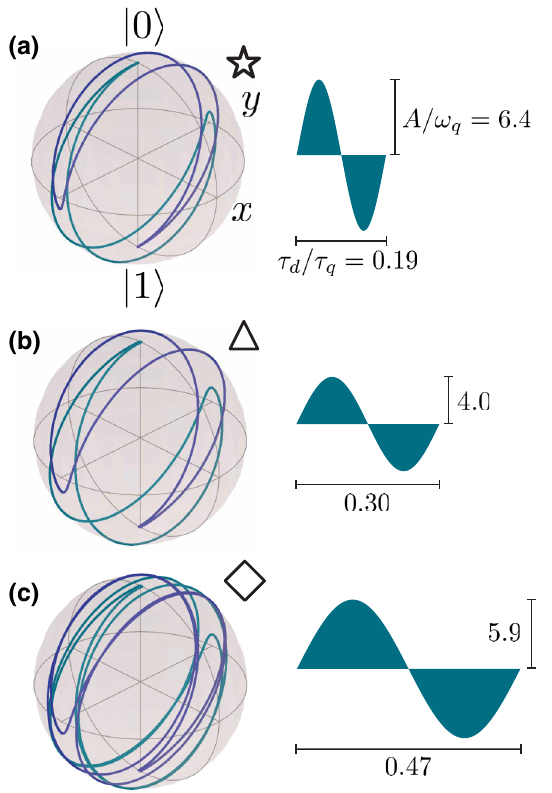
FIG. 7. (a)-(c) The Bloch-sphere trajectory in the laboratory frame of the initial states | 0 (cid:5) and | 1 (cid:5) subject to the pictured identity gates. The pulse parameters utilized here are marked in Fig. 6. Each gate achieves an identity operation with fidelity F ≥